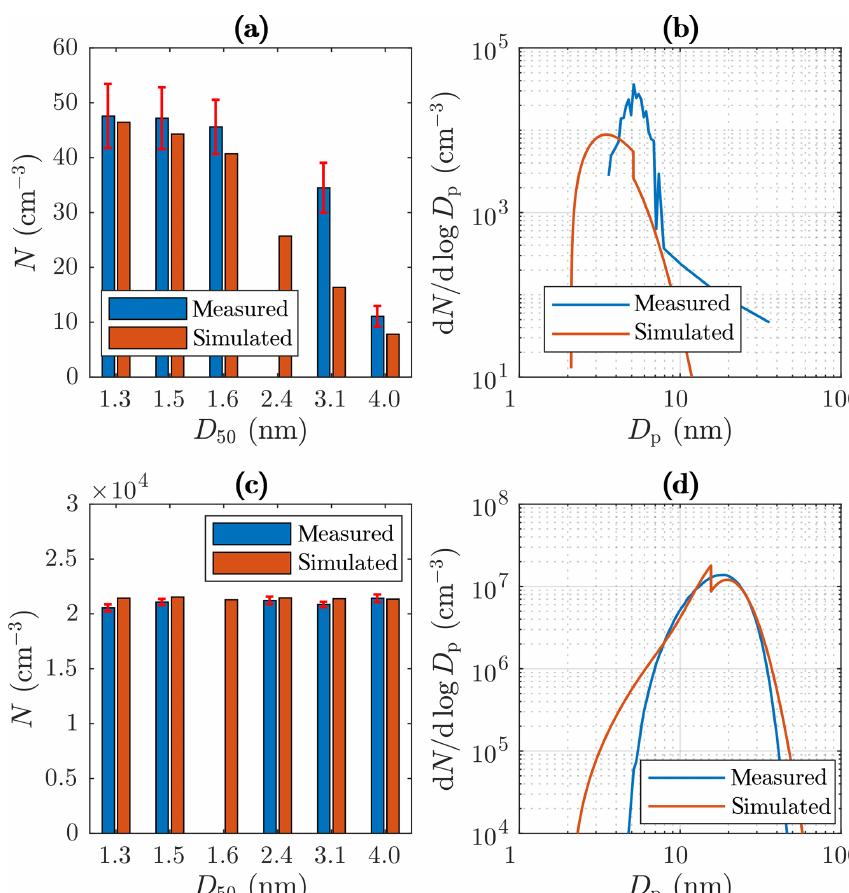
Figure 10. Examples of measured and simulated (a) number concentrations from the PSM and the CPC 3775 with T sa = 102 ◦ C, (b) size distributions from the Nano-SMPS with T sa = 102 ◦ C, (c) number concentrations from the PSM and the CPC 3775 with T sa = 157 . 2 ◦ C, and (d) size distributions from the Nano-SMPS with T sa = 157 . 2 ◦ C. The D 50 values in the range of 1.3–3.1nm represent the cut sizes of the PSM with different saturator flow rates, and the D 50 value of 4.0nm represents the cut size of the CPC 3775. The error bars in the measured concentrations represent the standard uncertainties caused by instability in the particle generation.